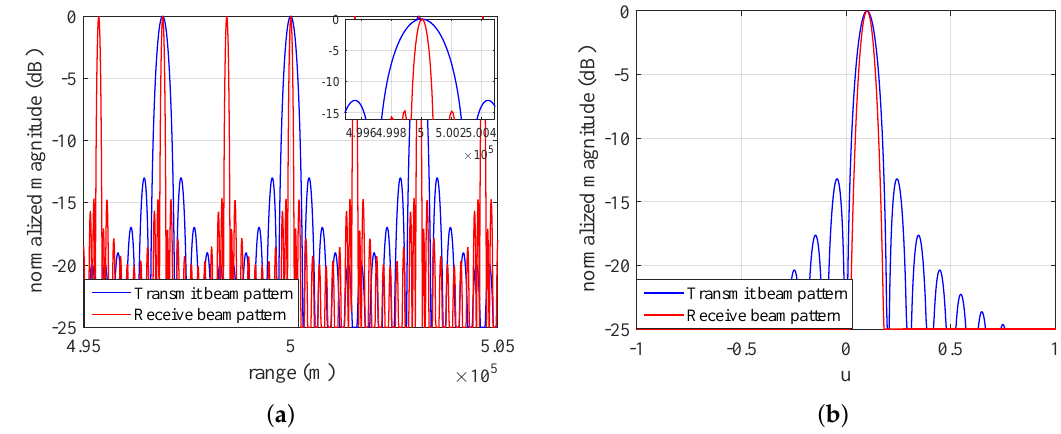
Figure 4. Slices of transmit and receive beampattern in ( a ) range and ( b )